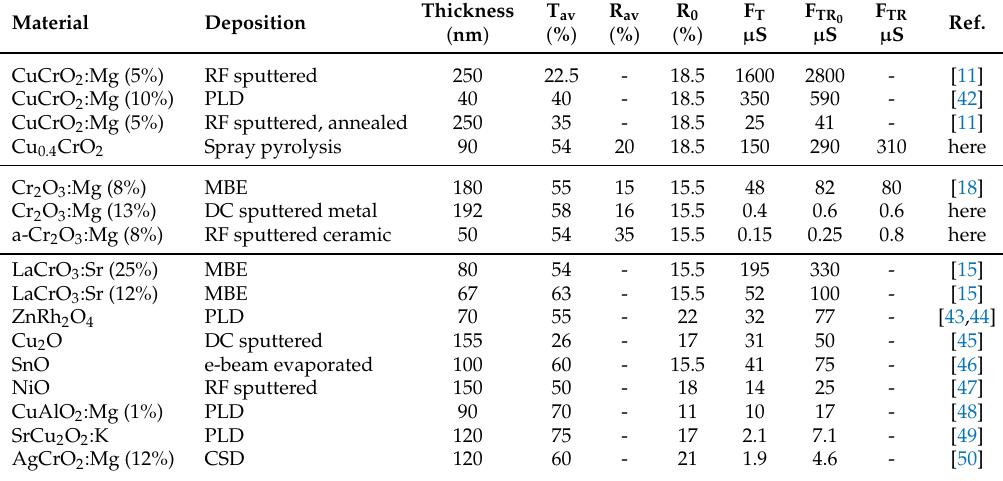
Table 1. Comparison of published data for p-type transparent conducting oxides. The sample thickness, conductivity, average transmission ( T av ) and, where available, average reflection were taken from the cited references. The figure of merit (FOM) F TR was calculated and compared to the often-used simplified version F T . Finally, we estimated R 0 using density functional theory (DFT) values [39,41] of n for cases where no reflectance data were available to calculate a more representative figure of merit F TR . The latter compares well to F TR in cases where measured reflectance data were available. 0 Note: there are many other publications for the given materials; priority was given here to the most complete datasets for all relevant properties, including those in Figure 1, not on earliest publication or